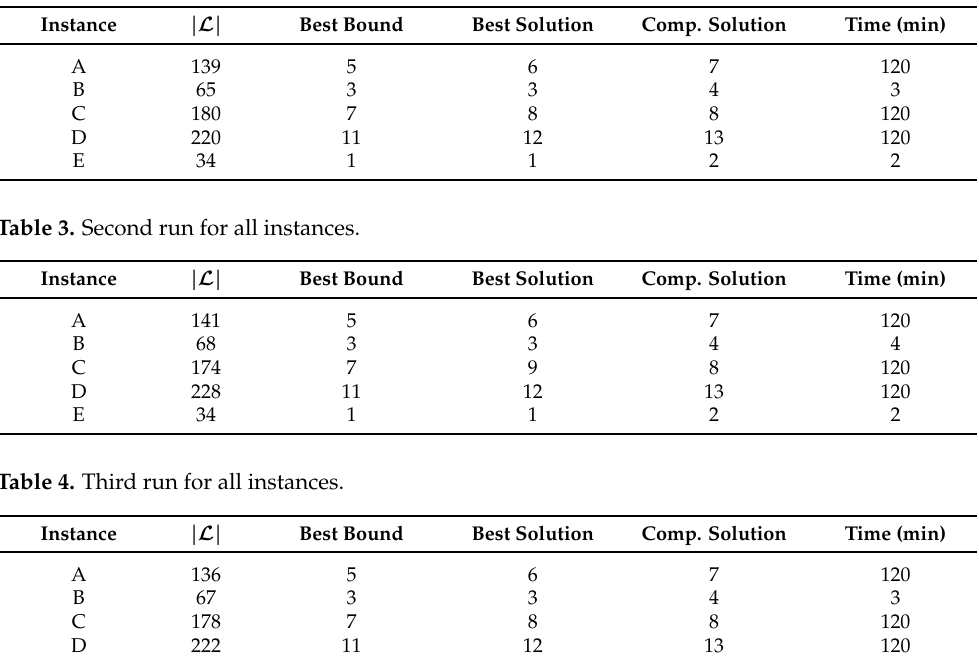
Table 2. First run for all instances.